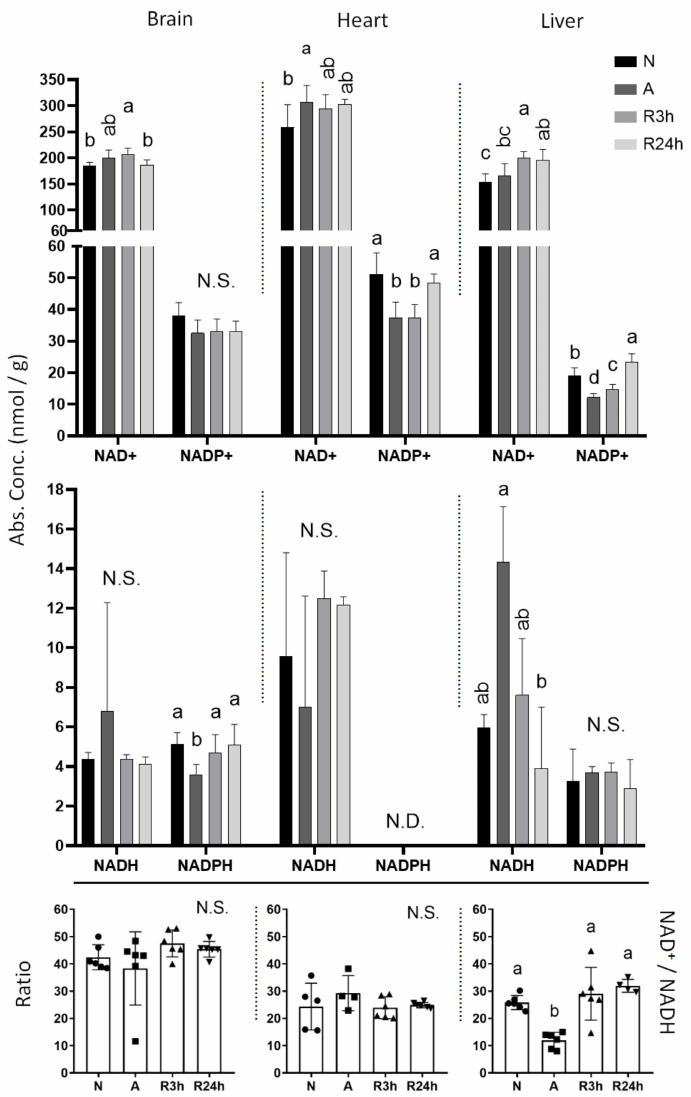
Figure A1. NAD + , NADH, NADP, NADPH, and NAD/NADH ratio. Graphs of absolute concentra- tions of NAD+, NADH, NADP, NADPH, and NAD + /NADH ratios for brain, heart, and liver. N, normoxia (control); A, anoxia; R3h, 3 h reoxygenation; R24h, 24 h reoxygenation. Different letters indicate statistical differences between groups calculated using one-way ANOVA with Tukey’s post- hoc ( p -value ≤ 0.05). Data are presented as means ± S.D. Values as reported by HMT. Individuals in which either NAD + or NADH was not detected were excluded from NAD + /NADH ratio